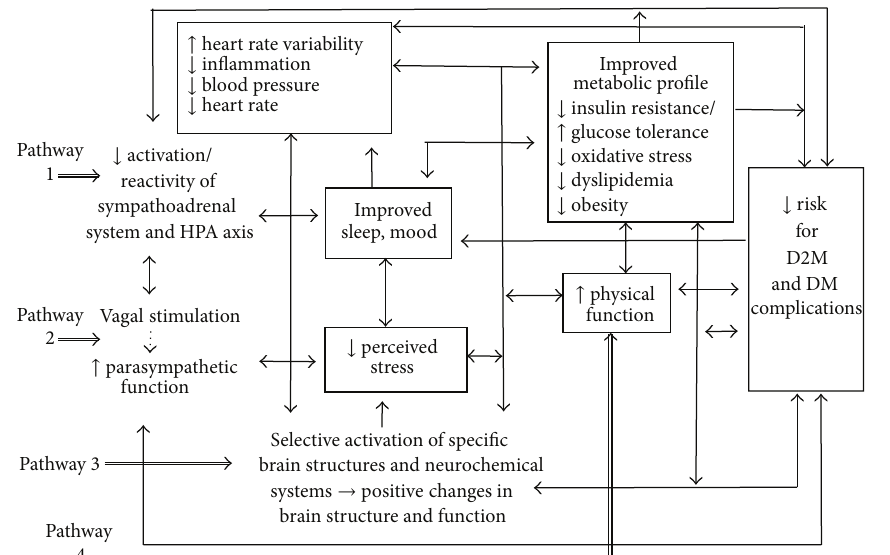
Figure 1: Some pathways by which yoga practices may influence outcomes in those with and at risk for type 2 diabetes (DM2). Figure adapted with permission from Hansen and Innes